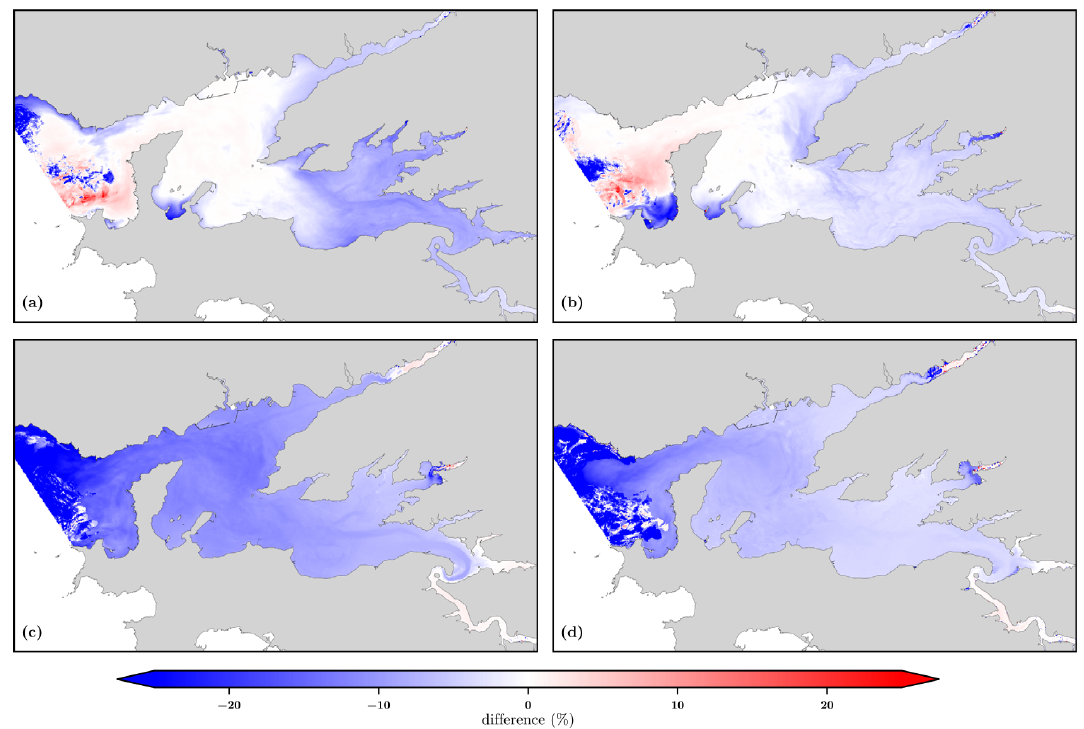
Figure 10. Differences between local e -folding flushing times estimated with one-way configuration over the two-way nesting method. They are computed for spring (a) and neap (b) tides in low-flow conditions and for spring (c) and neap (d) tides for flood conditions. Coastline source: